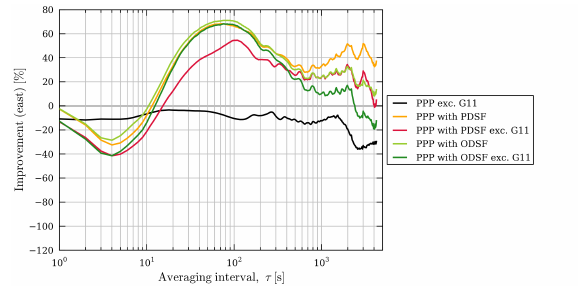
Figure 5: Figure showing the percentage improvement (i.e. reduc- tion) in Allan deviation in easting for station UEL, relative to the Allan deviation values corresponding to standard PPP processing that are shown in Fig. 4.